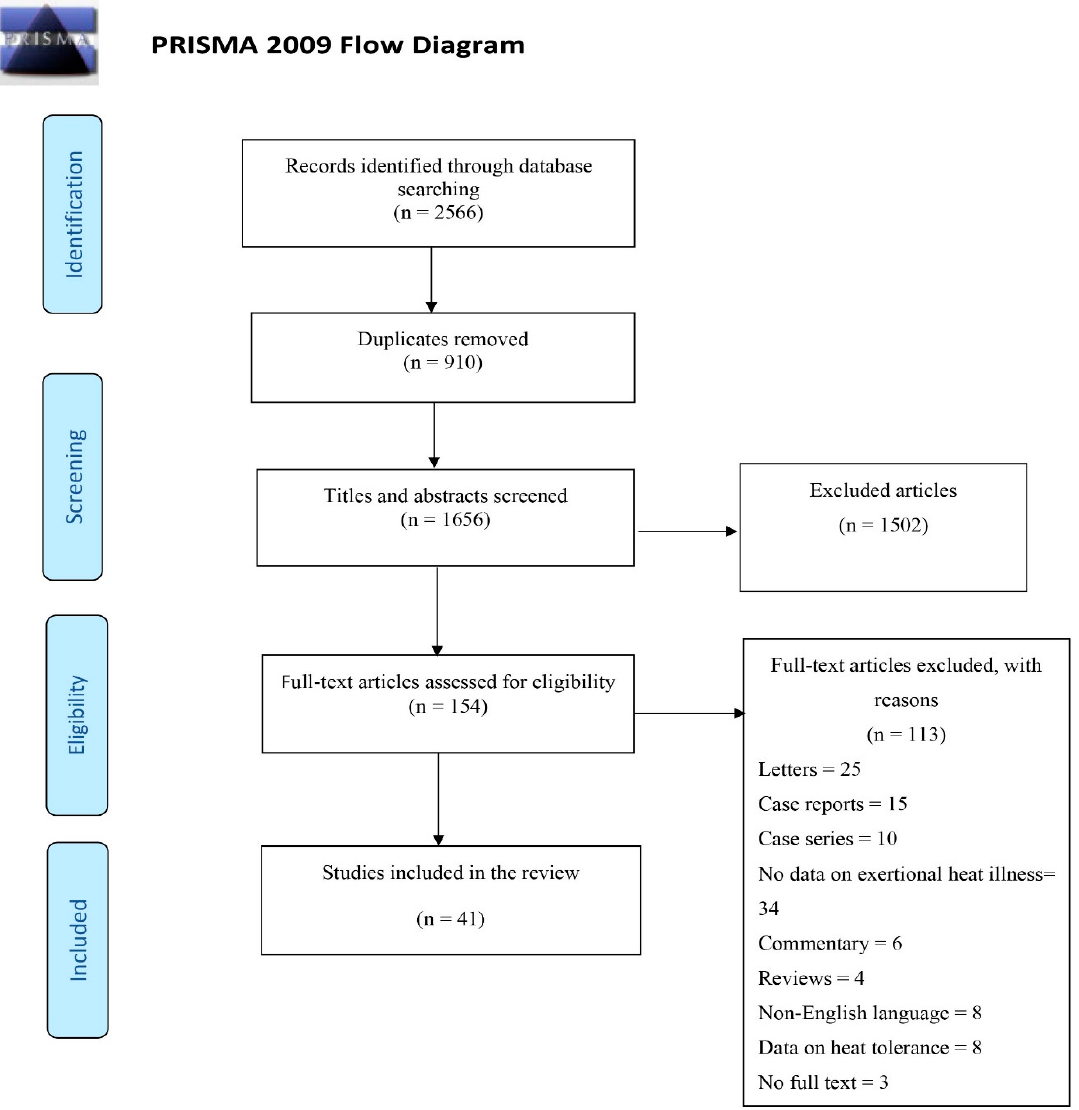
Figure 1. PRISMA flow chart of the systematic review selection process.